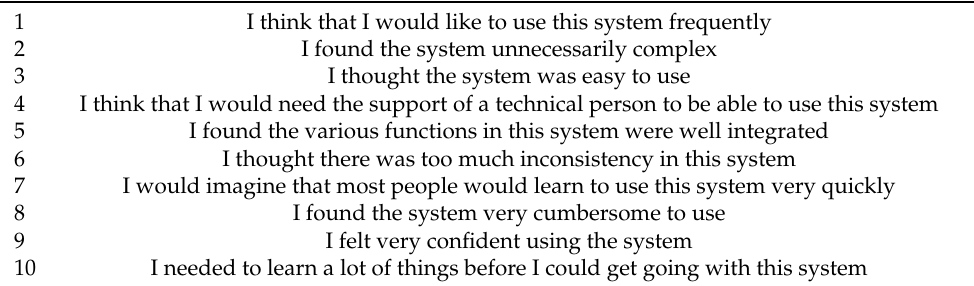
Table 2. The System Usability Scale (SUS)